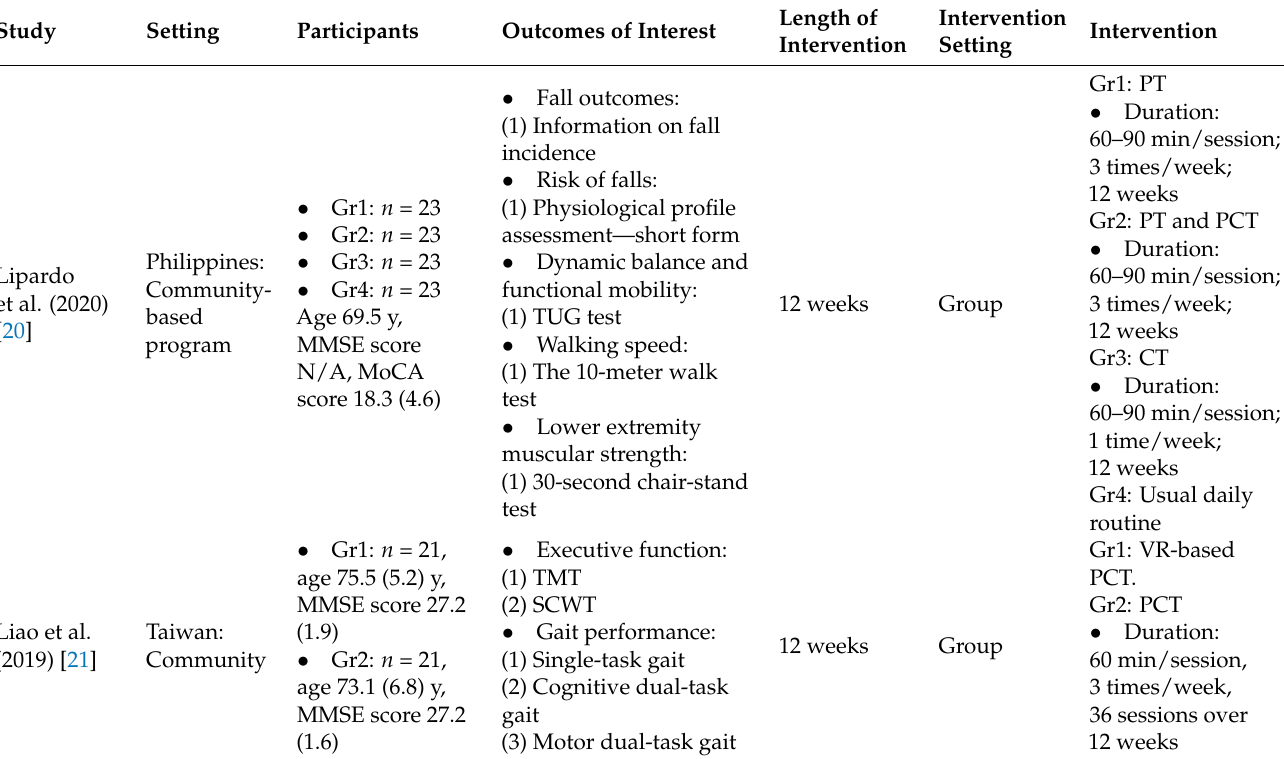
Table 1. Descriptive summary of fall-prevention intervention studies on the elderly with mild cognitive impairment (MCI) ( n =